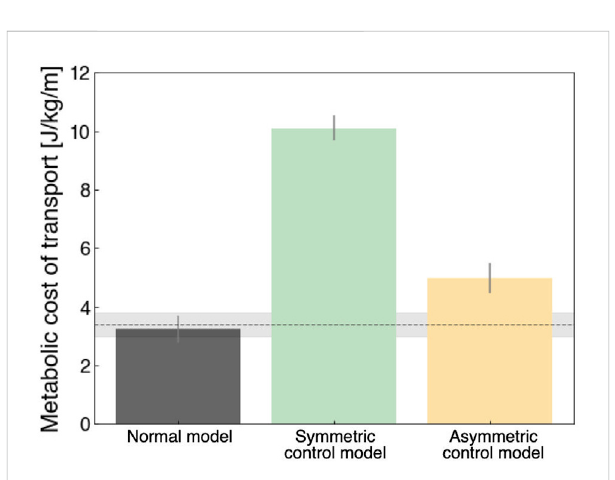
FIGURE 5 Metabolic costs of transport in each model. Each of these was calculated for 5 strides (3rd to 8th strides). Grey, green, and yellow colors indicate the normal model, symmetric control model, and asymmetric control model, respectively. The horizontal line indicatesthemeasureddataofable-bodiedindividuals,with avalueof 3.40 ± 0.4 J/kg/m (Das Gupta et al.,